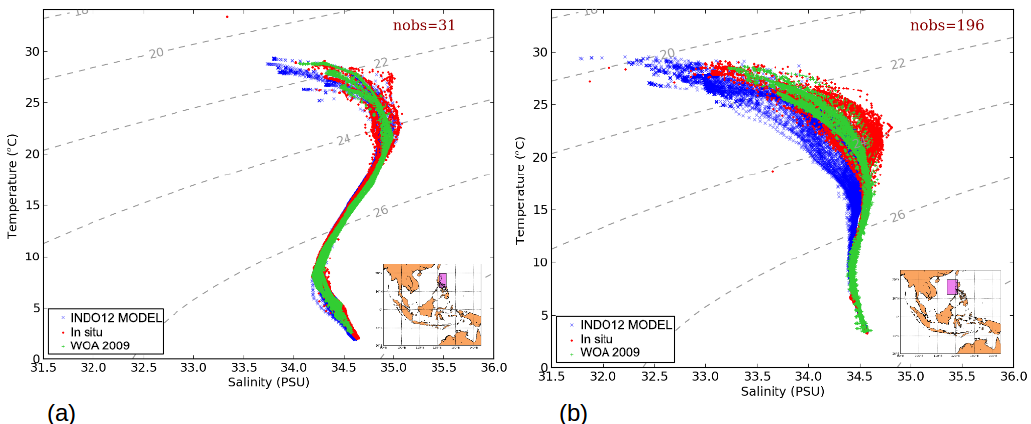
Figure 22. Collocated T – S diagrams to in situ data (red) from INDO12 simulation (blue) and from climatology WOA2009 (green) on both sides of the Luzon Strait (purple square) from October to December 2013. Salinity (PSU) and temperature ( ◦ C) are plotted along x and y axes,